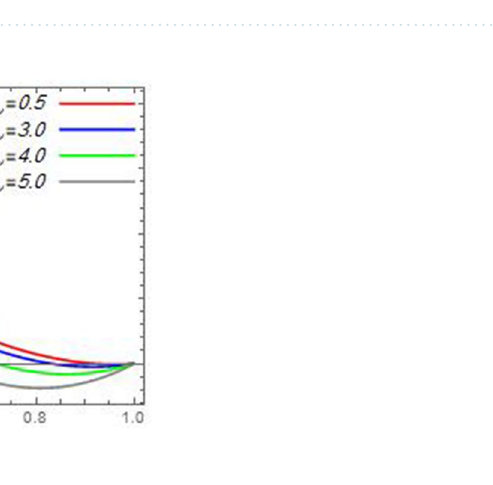
Figure 2. The radial velocity F versus the axial variable η in the case of stationary disc to depict the effect of the Reynolds number Re Ω .